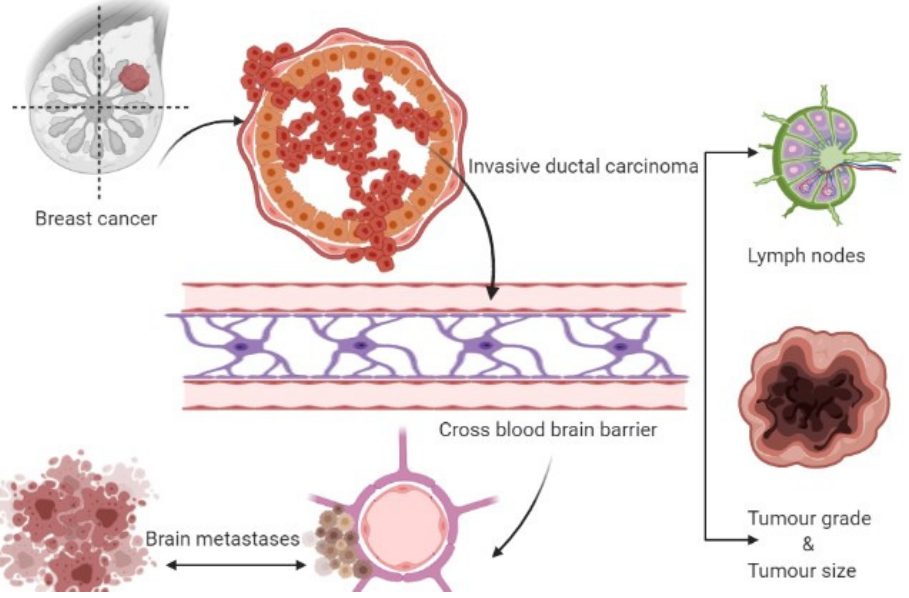
Figure 1. Formation of breast cancer-associated brain tumors.